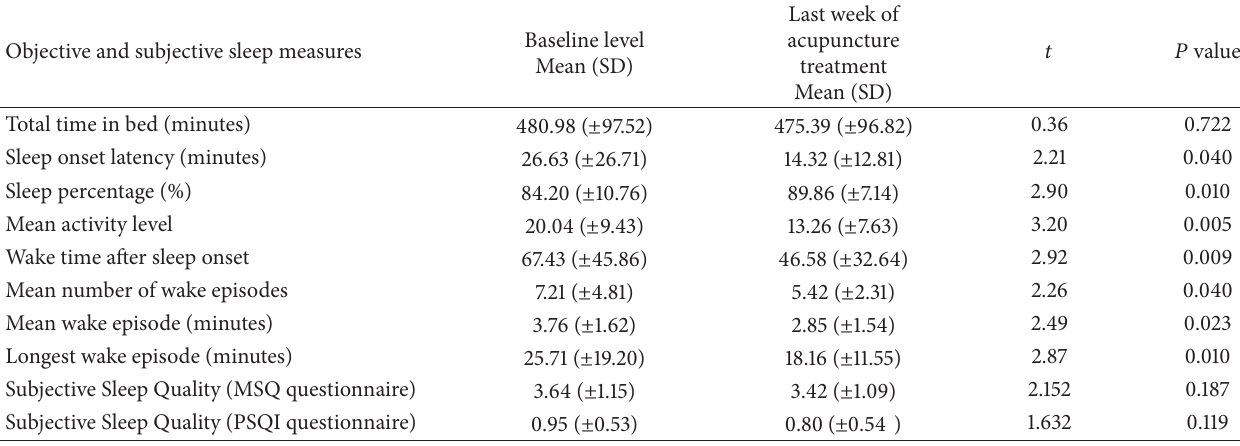
Table 1: Objective and subjective sleep measures (means and standard deviations) after each phase of the study and analysis of the comparisons between them.